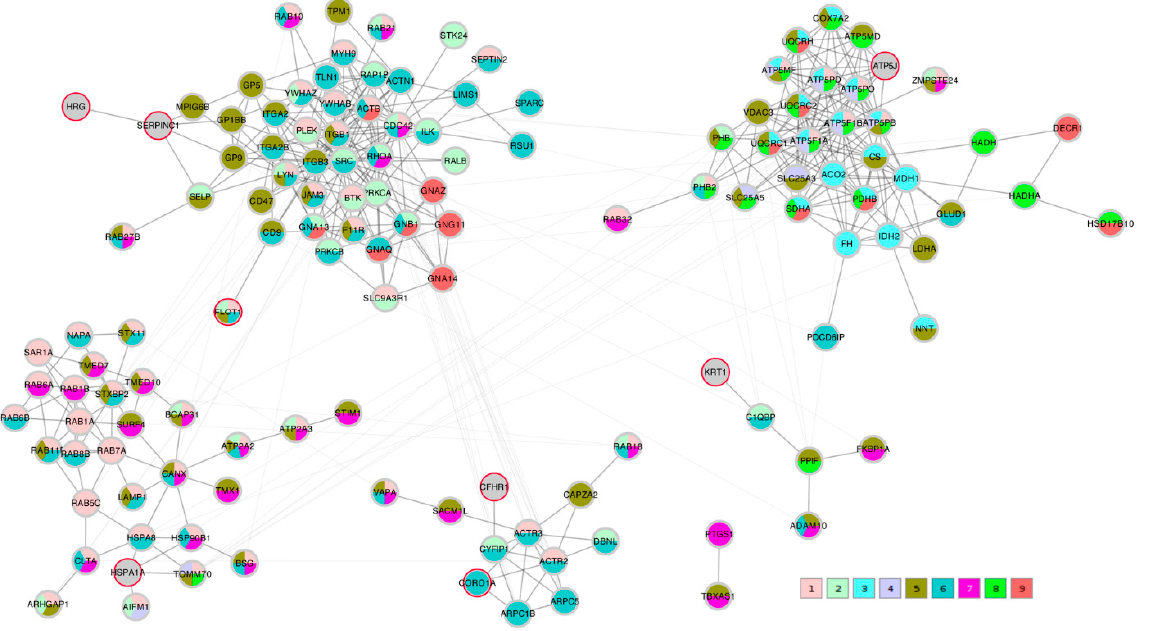
Figure 7. STRING protein-protein interaction network composed of proteins that were significantly correlating with the PTS transport metric VDV (PTS_VDV) and the Lasso proteins. Edges represent a STRING combined score ≥ 0.7; they are drawn thick within community clusters, and thin across community clusters. Lasso proteins are marked with a red border (gray otherwise). Node colors at the bottom right refer to GO terms given in Table 4, with 1–4 standing for biological process and 5–9 cellular component.